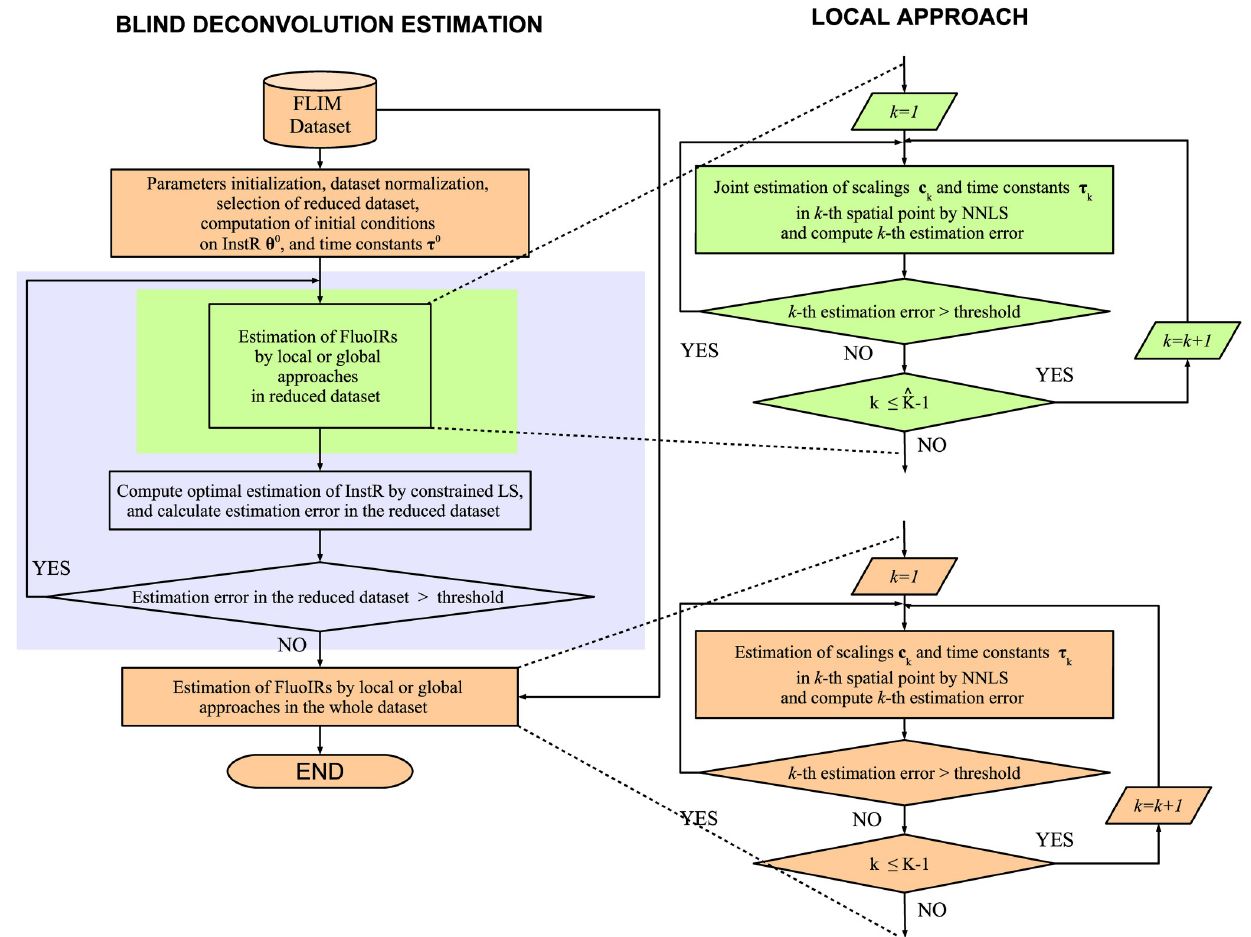
Fig 2. Blind deconvolution estimation: Local approach. Block diagram of the general methodology with local approach to estimate FluoIRs.